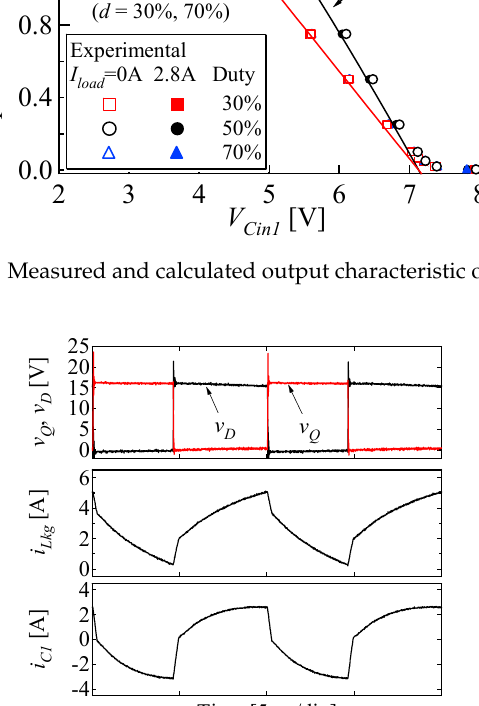
Figure 16. Measured key operation waveforms at V load = 8.0 V and I load = 2.8 A.